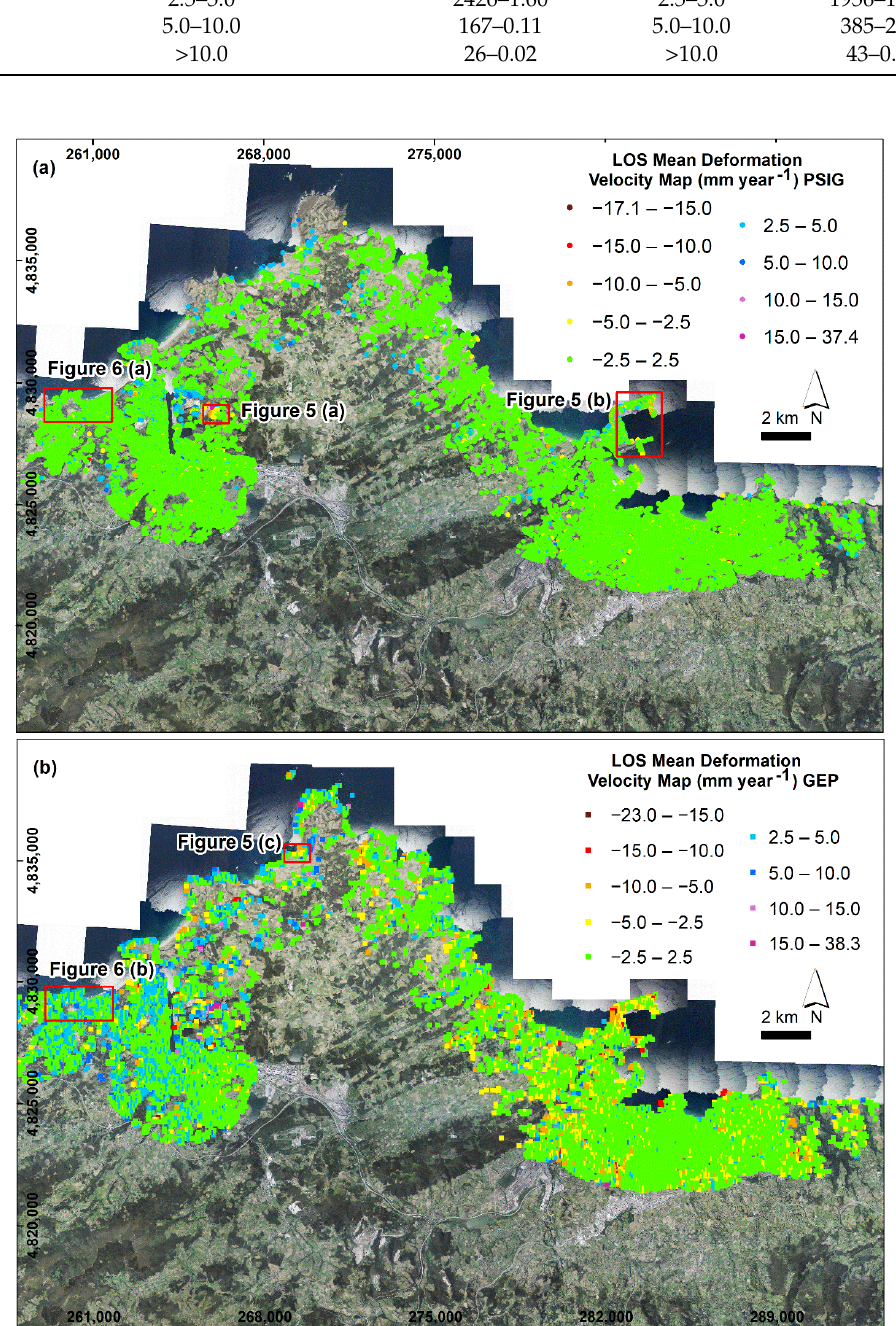
Figure 4. ( a ) LOS mean deformation velocity map in mm year − 1 obtained by PSIG software; ( b ) LOS mean deformation velocity map in mm year − 1 obtained by GEP service; the red squares are the selected deformation areas for local analysis. OrtoPNOA 2017 CC-BY 4.0 scne.es.